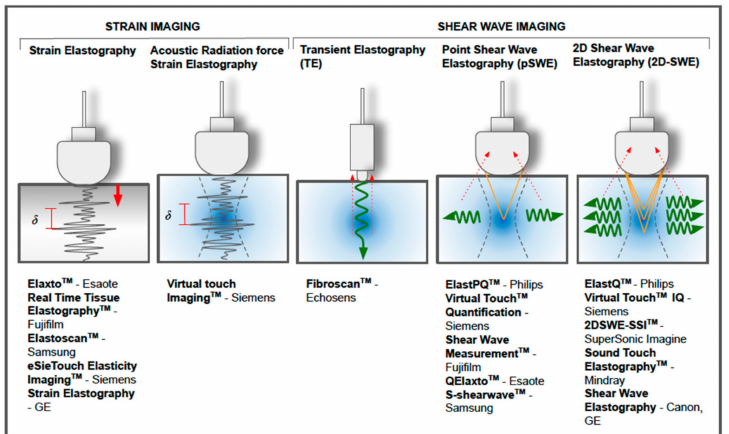
Figure 14. Different techniques of ultrasound-based elastography and some of the commercial devices that are currently